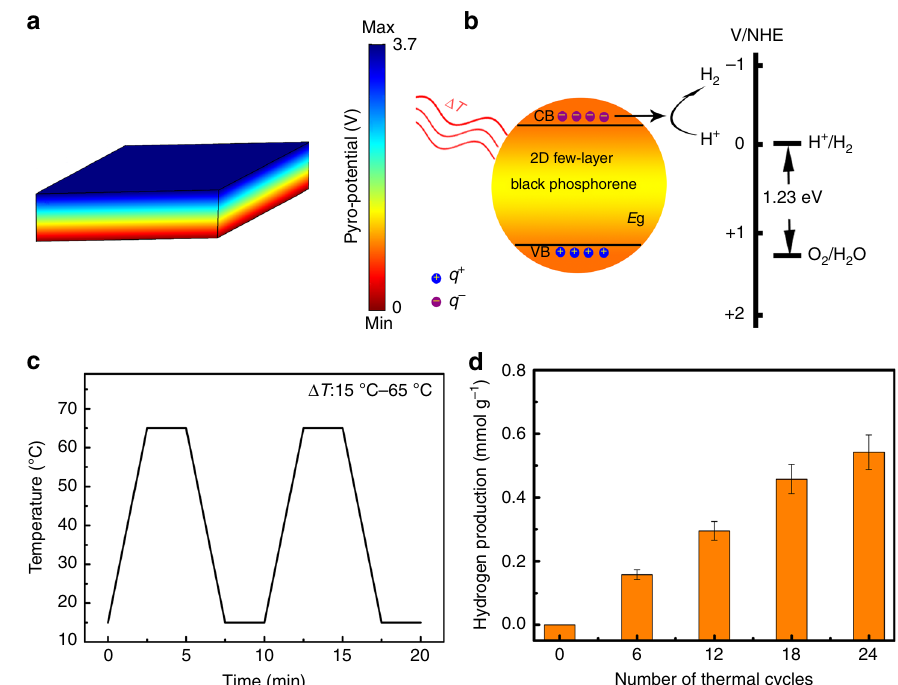
Fig. 5 Pyro-catalysis of 2D-BP for hydrogen production from water splitting. a The COMSOL simulation of the pyro-potential. b Schematic diagram for hydrogen production through pyroelectric effect. c The temperature curve of the typical cold – hot thermal cycles from 15 to 65 °C. d Pyro-catalytic hydrogen production Figure 5c shows the temperature curve of typical thermal cycles between 15 and 65 °C. The corresponding hydrogen production during cycling is shown in Fig. 5d, where the rate of hydrogen production is around 22.5 μ mol g − 1 per thermal cycle. After 24 thermal cycles, the total hydrogen production per gram of catalyst is up to 0.54 mmol.